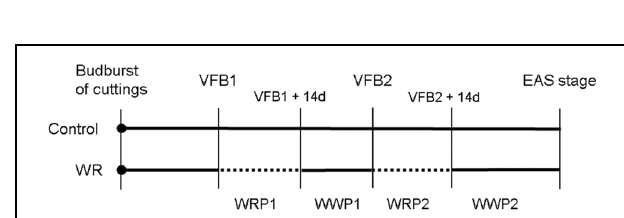
FIGURE 1 | Plant photography before phenotyping by 3D digitalization (A); plant architecture with two components (metamer and axis; B); simplified representation with three branching orders: Order 1 (O1), Order 2 (O2), and Order 3 (O3; C).